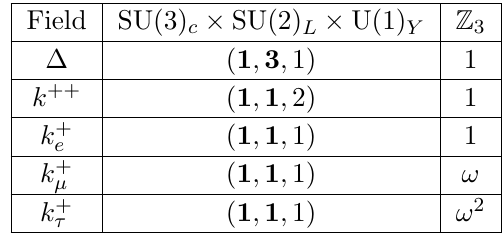
Table 2 . Quantum numbers of the additional (cid:12)elds in Scenario A under the SM gauge group and Z 3